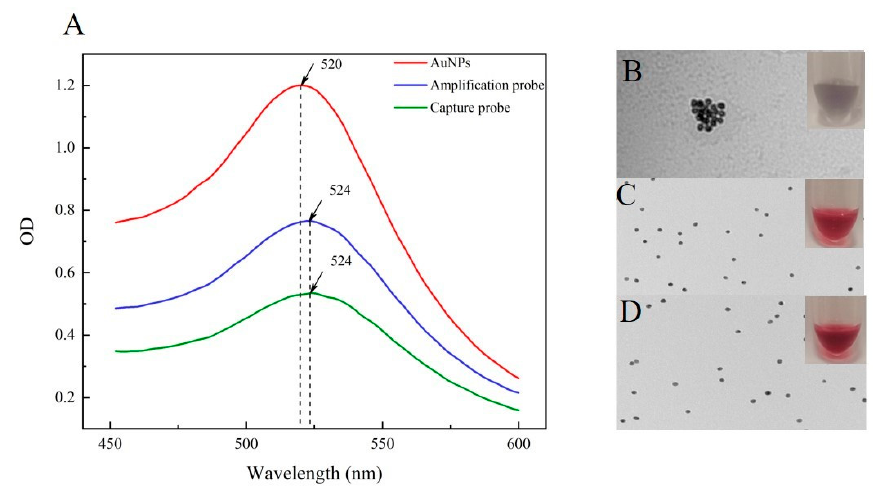
Figure 3. Characterization of the AuNPs and AuNPs–probe: UV absorption spectra peak alteration of original AuNPs, amplification probe and capture probe ( A ); TEM images and photographs of original AuNPs ( B ), amplification probe ( C ), and capture probe ( D ) reaction with 2 M NaCl.